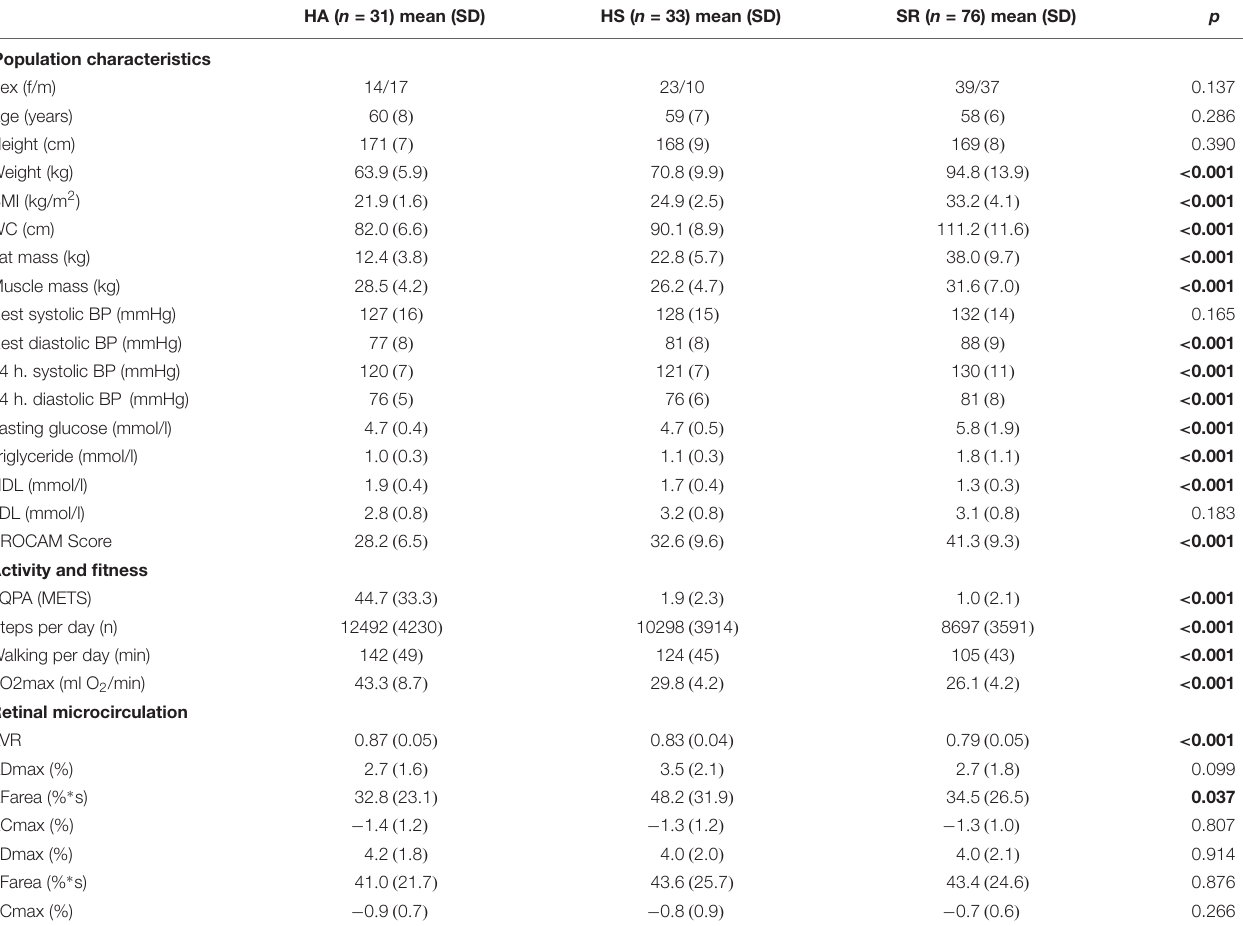
TABLE 1 | Overall population